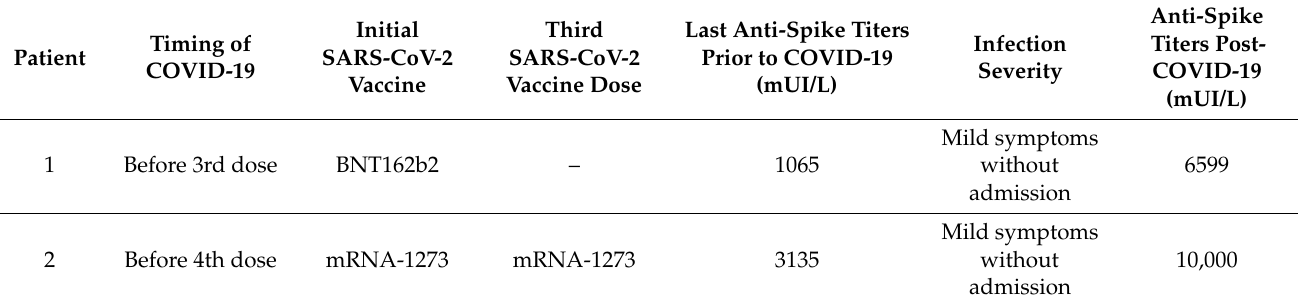
Table 2. Characteristics of patients that developed COVID-19 during